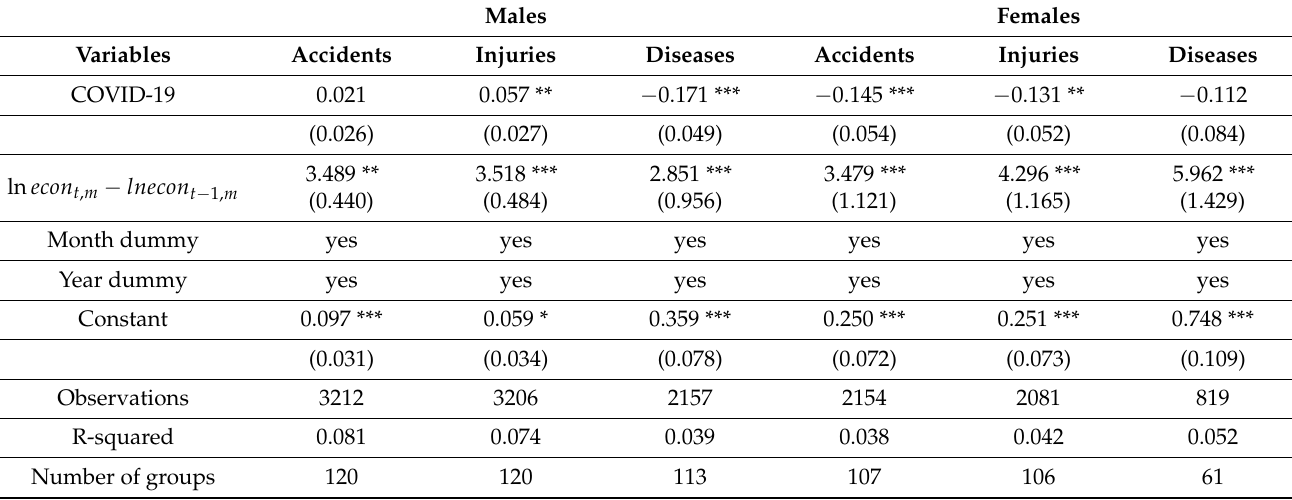
Table 4. Estimation results of fixed effects models by gender. Males